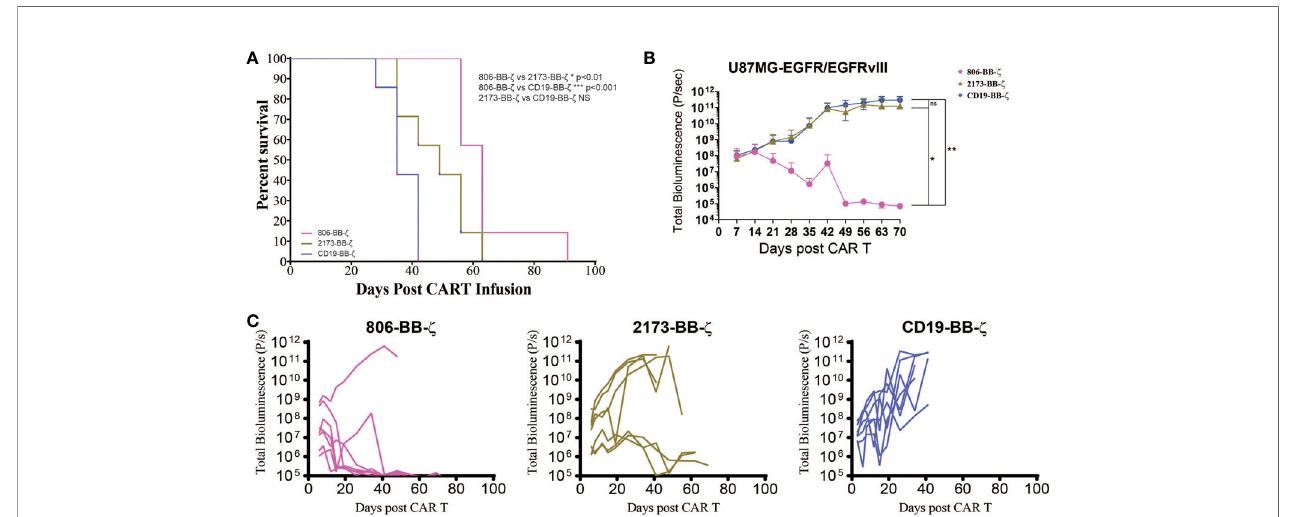
FIGURE 4 | In vivo antitumor effect of 806 CAR T cells in NSG mice bearing U87MG-EGFR/EGFRvIII + xenografts. Seven days after 250,000 U87MG-EGFR/EGFRvIII cells were subcutaneously implanted into mice, 3 × 10 6 T cells were injected intravenously with indicated CAR constructs. (A) Survival based on time to endpoint was plotted using a Kaplan – Meier curve and statistically signi fi cant differences between CAR groups were determined using the log-rank Mantel-Cox test. Tumor burden was assessed by bioluminescent imaging. Bars indicate means ± SD (n = 7 mice per group). Tumor burden was quanti fi ed as total fl ux (B) and in individual mice (C) in units of photons/second. Bars indicate means± SD (n = 7 mice). P = photons. ns, p > 0.05; *p ≤ 0.05; **p ≤